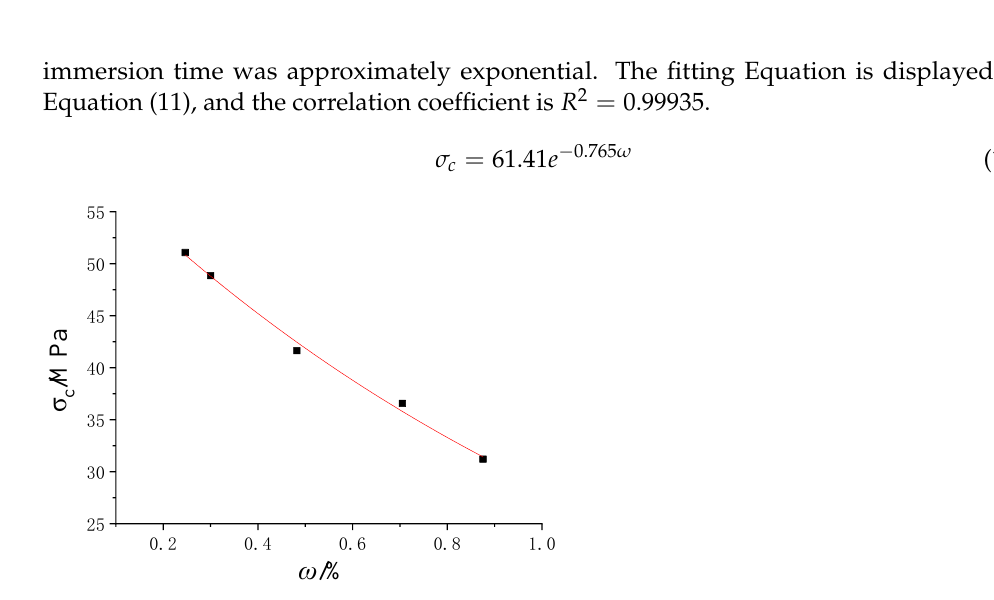
11 of 17 in water for 7 days, the triaxial compressive strength of the gypsum rock was 41.64 MPa, this being 18.48% lower than that in the natural state. After immersion in water for 15 days, the triaxial compressive strength of the gypsum rock was 36.56 MPa, this being 28.43% lower than that in the natural state. After immersion in water for 30 days, the tri- axial compressive strength of the gypsum rock was 31.21 MPa, this being 38.90% lower